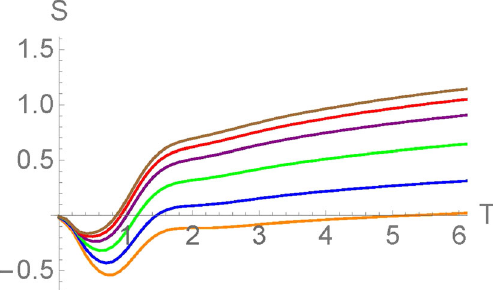
Fig. 11 Entropy for the ’sine-Gordon’ comb as a function of T for: (cid:5) = 0 . 1 (orange line), (cid:5) = 0 . 25 (blue line), (cid:5) = 0 . 5 (green line), (cid:5) = 0 . 75 (purple line), (cid:5) = 0 . 9 (red line) and (cid:5) = 1 (brown line). We have chosen for the lattice spacing a =